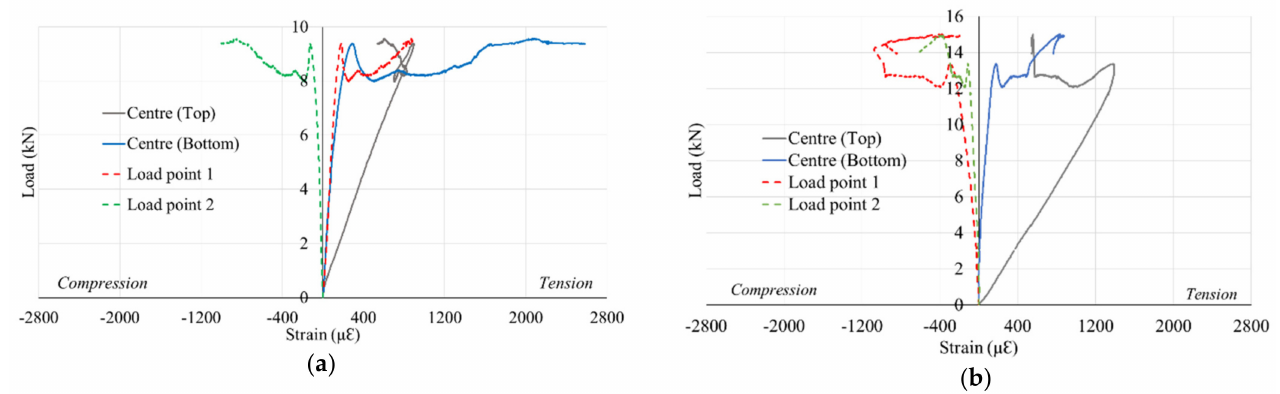
Figure 11. ( a ) Load vs. strain curves of double cell panel. ( b ) Load vs. strain of triple cell